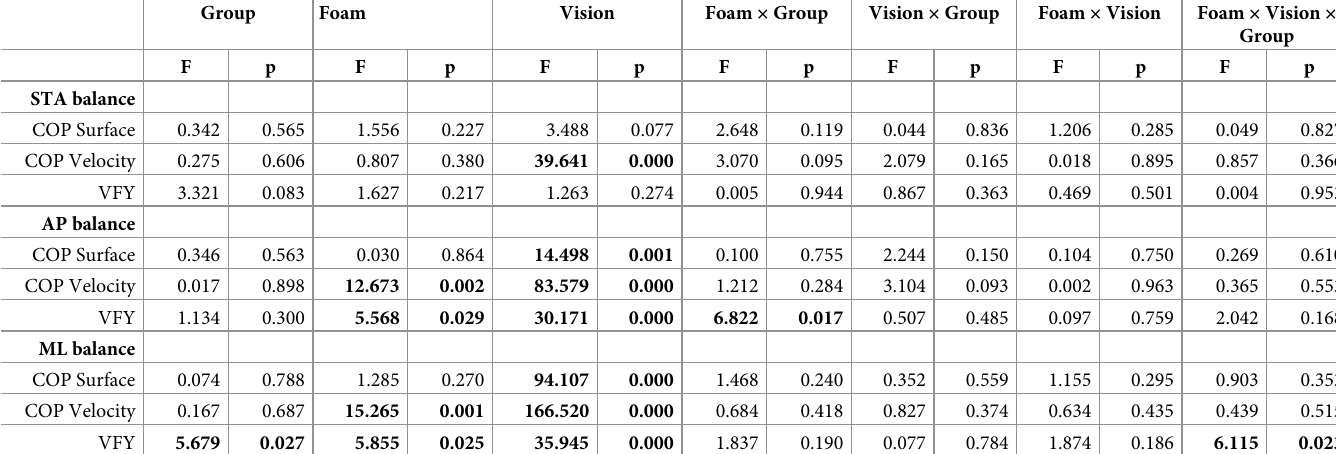
Table 2. Level of Group × Foam × Vision ANOVAs main and interaction effects conducted on COP surface, COP velocity, VFY for the three balances (STA, AP, ML). Significant differences are indicated in bold (p < 0.05). Group